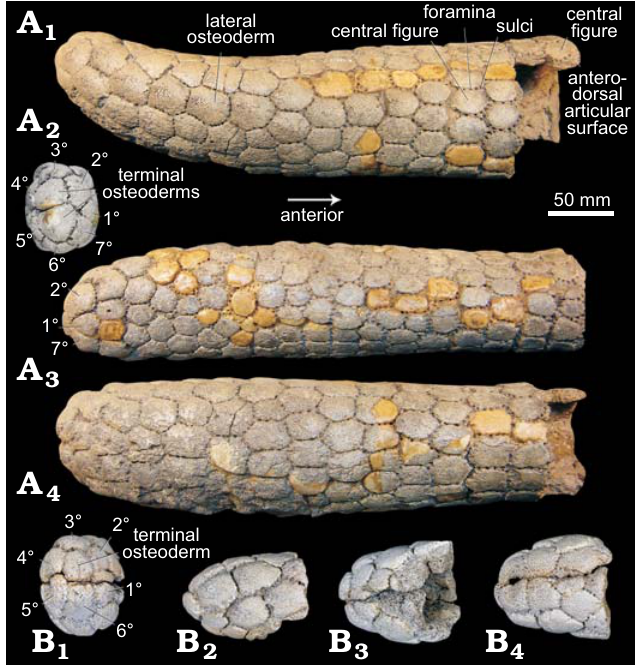
Fig. 4. Caudal tubes of old specimens, syntype and assigned specimens of Palaehoplophorus meridionalis Ameghino, 1904 from Río Fénix, Lago Blanco, and “Rionegrense”, Patagonia, Serravallian–Tortonian, middle– late Miocene. A . MACN A 11737, syntype, in lateral (A 1 ), distal (A 2 ), dor- sal (A 3 ), and ventral (A 4 ) views. B . MACN A 11132, in distal (B 1 ), lateral (B 2 ), dorsal (B 3 ), and ventral (B 4 ) views.